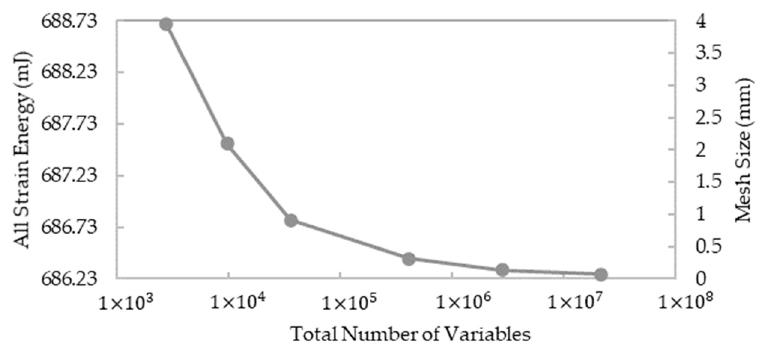
Figure A2. Mesh convergence for global strain energy value.